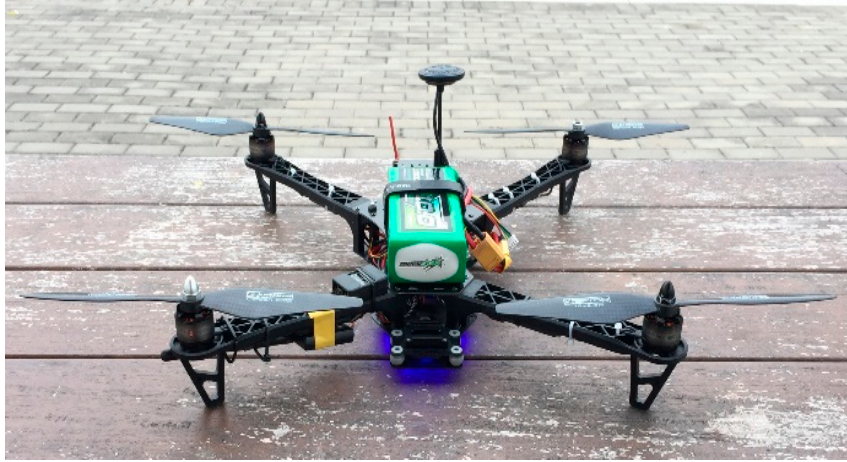
Figure 2. F450 spider quadcopter. Table 1. Specifications of the F450 spider quadcopter.